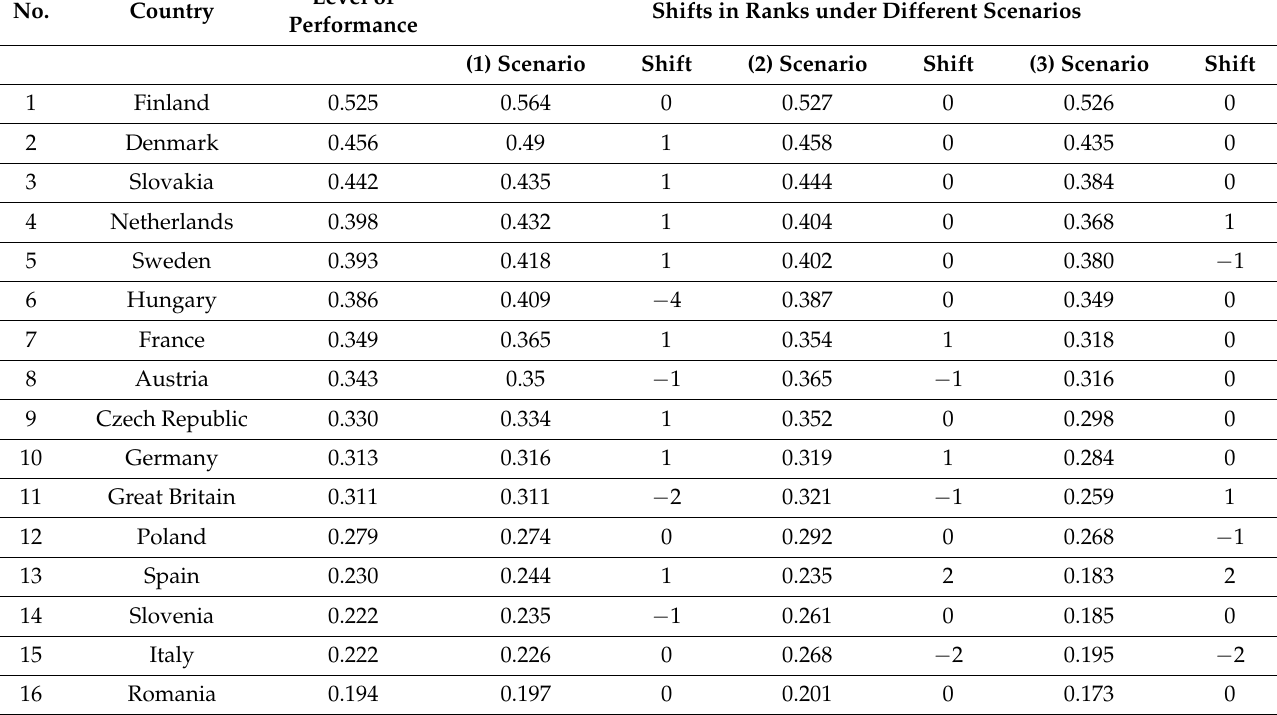
Table 8. Robustness